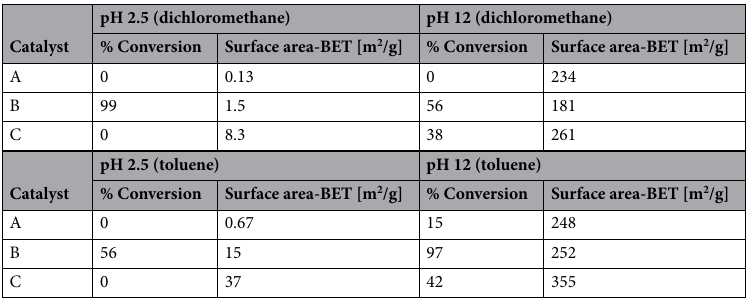
Table 1. Effects of matrix entrapment of type 2 catalysts (A–C) on conversion and surface area values of the matrix * for its first cycle in dichloromethane (I) or toluene (II) as a solvent ** . *Sol–gel matrix was prepared with TMOS at pH 2.5 or at pH 12. ** RCM of DDM reaction 1 Conditions: Reaction time: 24 h; Catalyst: A-C (catalyst initial = 1.0 . 10 –6 mol); Molar ratio (between the catalyst and the substrate) 5%. Max leakage equals 1%, which was found by